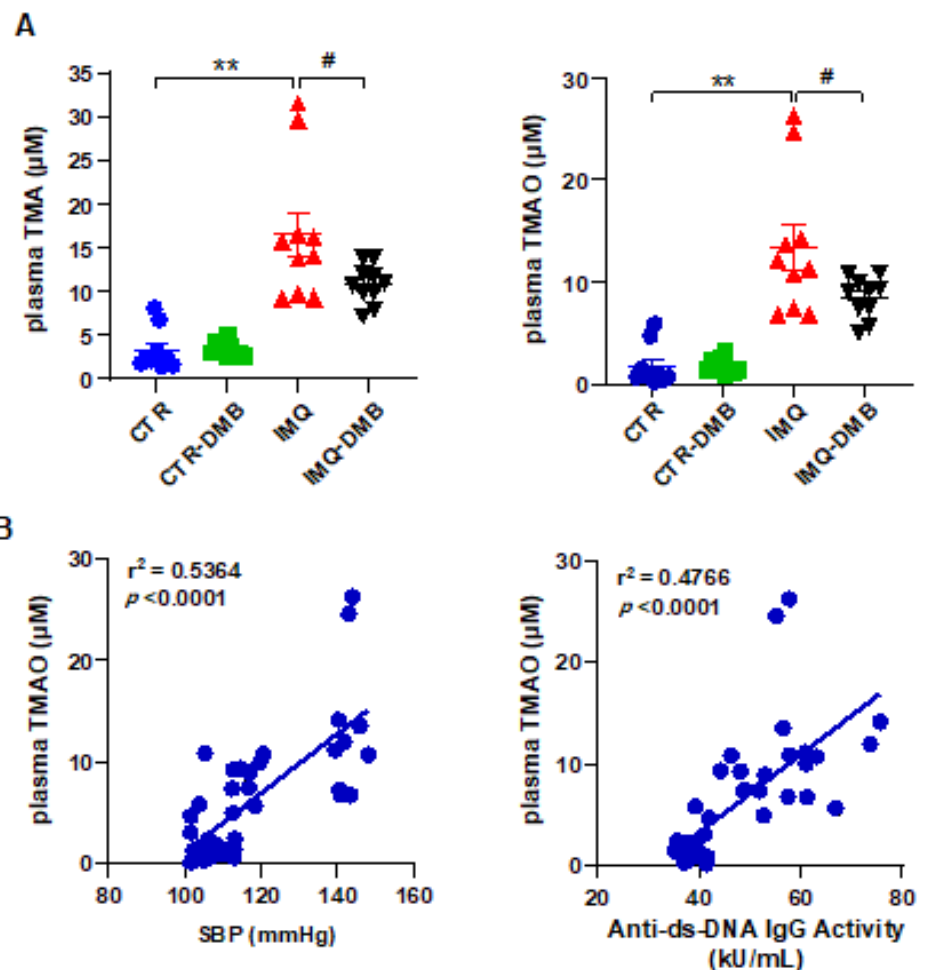
Figure 3. Plasma TMAO was correlated to systolic blood pressure and SLE disease activity. ( A ) Plasma TMA and TMAO levels in control (CTR), CTR-group treated with 3,3-dimethyl-1-butanol (DMB) (CTR-DMB), IMQ, and IMQ-group treated with DMB (IMQ-DMB). The data are represented as means ± SEM. One-way ANOVA and Tukey’s multiple comparison test were performed. ** p < 0.01 when compared to CTR; # p < 0.05 when compared to IMQ. ( B ) Pearson correlation between plasma TMAO and SBP or anti-ds-DNA activity using data from all experimental groups.